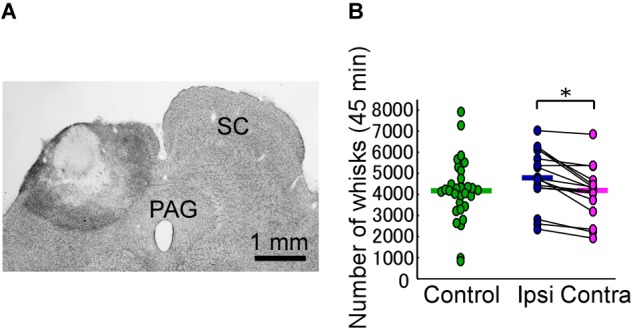
Unilateral lesion of the SC leads to differences in the occurrence rate of bilateral vibrissal reciprocating motions (whisks). (A) The extent of the SC lesion for a representative rat. (B) Numbers of whisks in each of the rats (45 min/day for 3 days). Horizontal lines indicate the median numbers of whisks. ∗p < 0.05 using Wilcoxon ranked-sum test (ipsi vs. contra). SC, superior colliculus; PAG, periaqueductal gray; ipsi, side ipsilateral to the lesion; contra, side contralateral to the lesion.